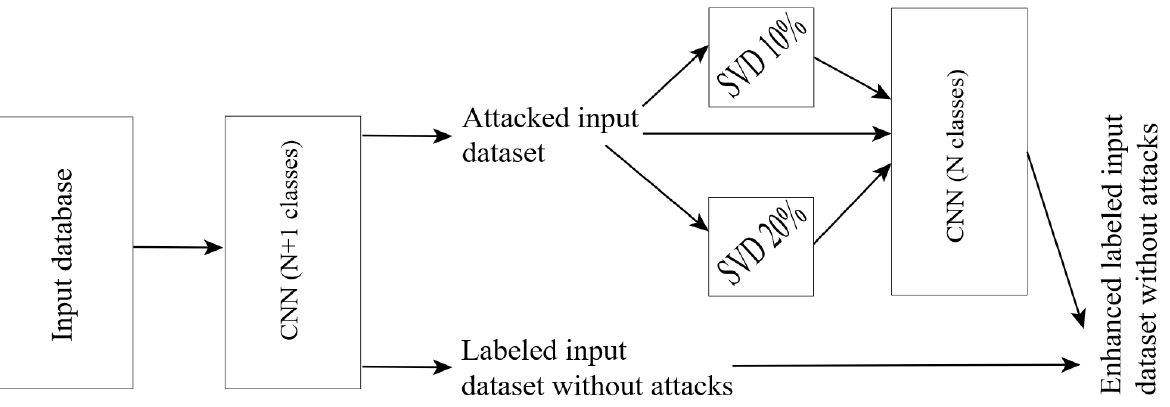
Figure 4. Flowchart to combat visual attacks.